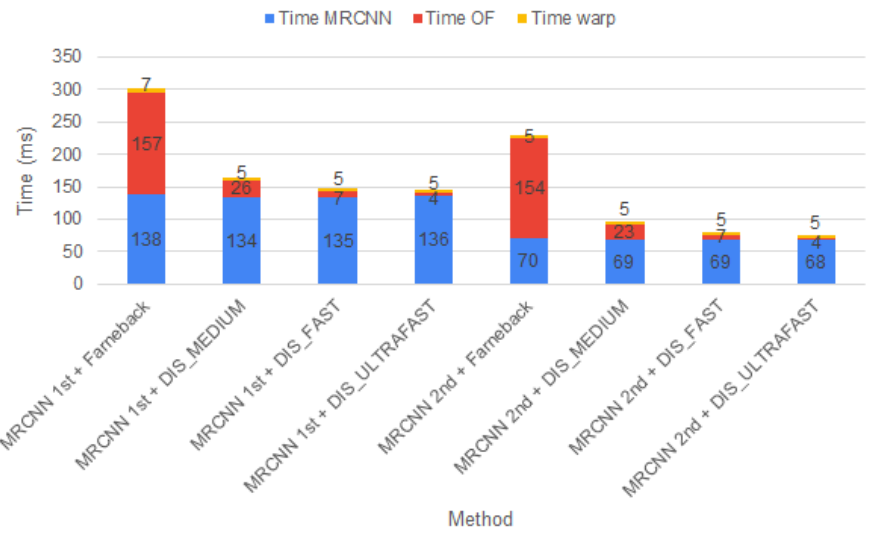
Figure 11. Mask RCNN, Optical Flow and Warp time, own